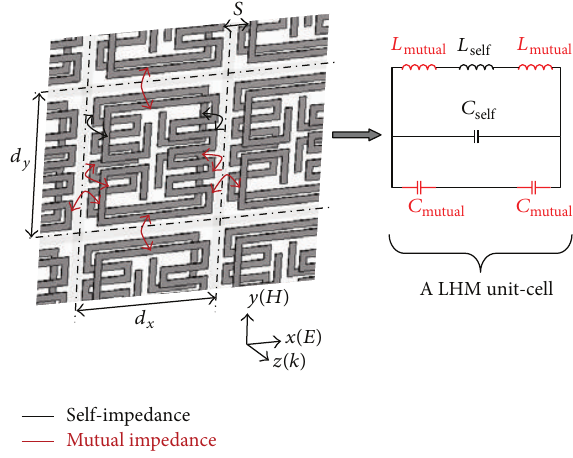
Figure 1: LHM substrate is created by periodic arrays of LHM unit- cells (left) and the equivalent circuit of a unit-cell (right); excitation waves (from the reference antenna) are coming to LHM substrate in 𝑧 direction.